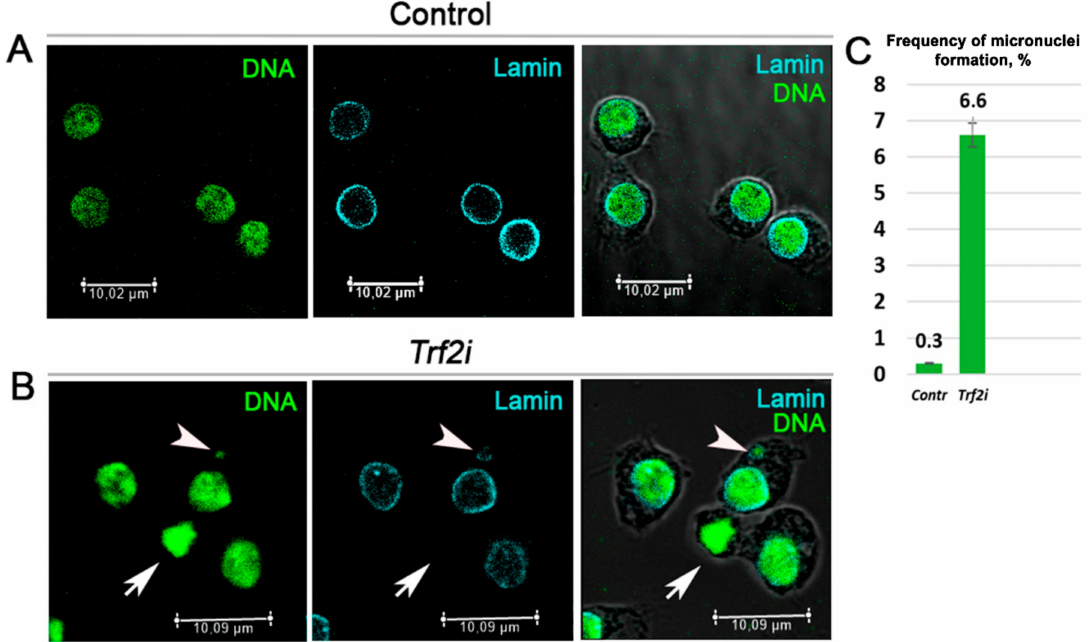
Figure6. RNAi-mediateddepletionofTrf2leadstomicronucleiformationanddisturbsnuclearenvelope. Confocal immunofluorescence images of Drosophila S2 cells ( A ) before and ( B ) after RNAi-mediated silencing of Trf2 . Cells were stained for SytoxGreen to highlight DNA (green) and anti-Lamin Dm to visualized nuclear envelope (cian). The third column represents merged images. Arrowheads pointe to micronucleus, arrows indicate Lamin negative nuclear envelope. ( C ) Quantification of cells with micronuclei from control (Contr, n = 350) and Trf2 dsRNA transfected cells ( Trf2i , n = 229) from three independent experiments. A p -value from Student’s t -test was 0.0047. Error bars: